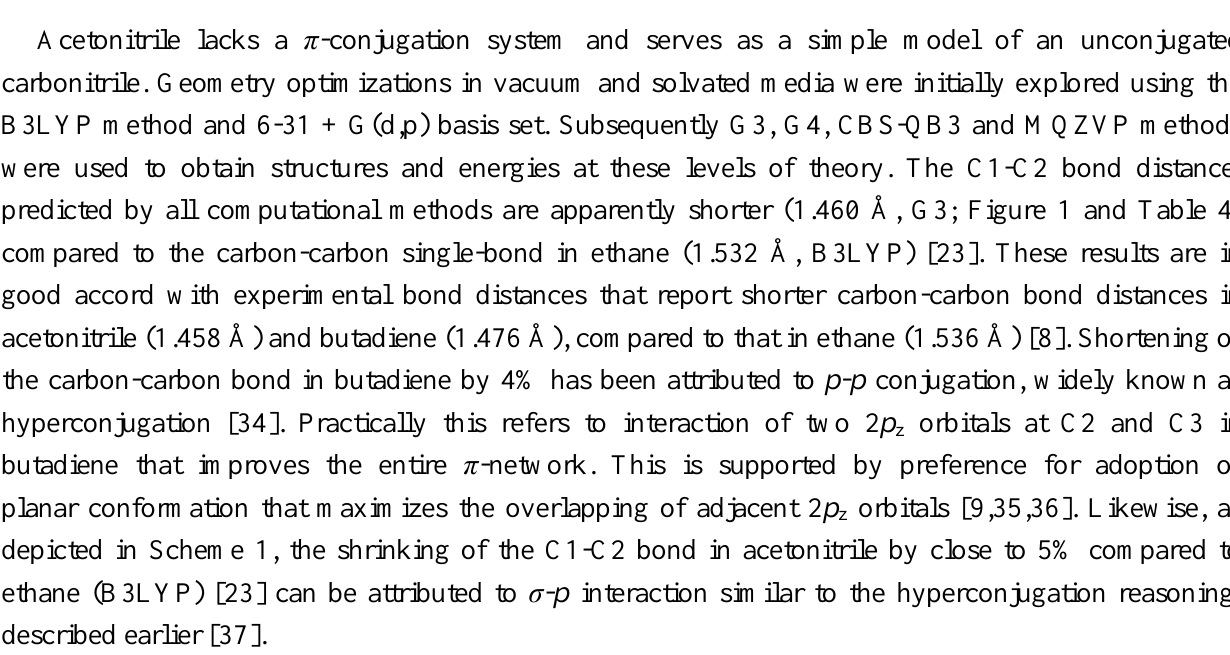
Table 3. G3 and G4 geometries and binding energies of Mg(II) complexes with HCN and H